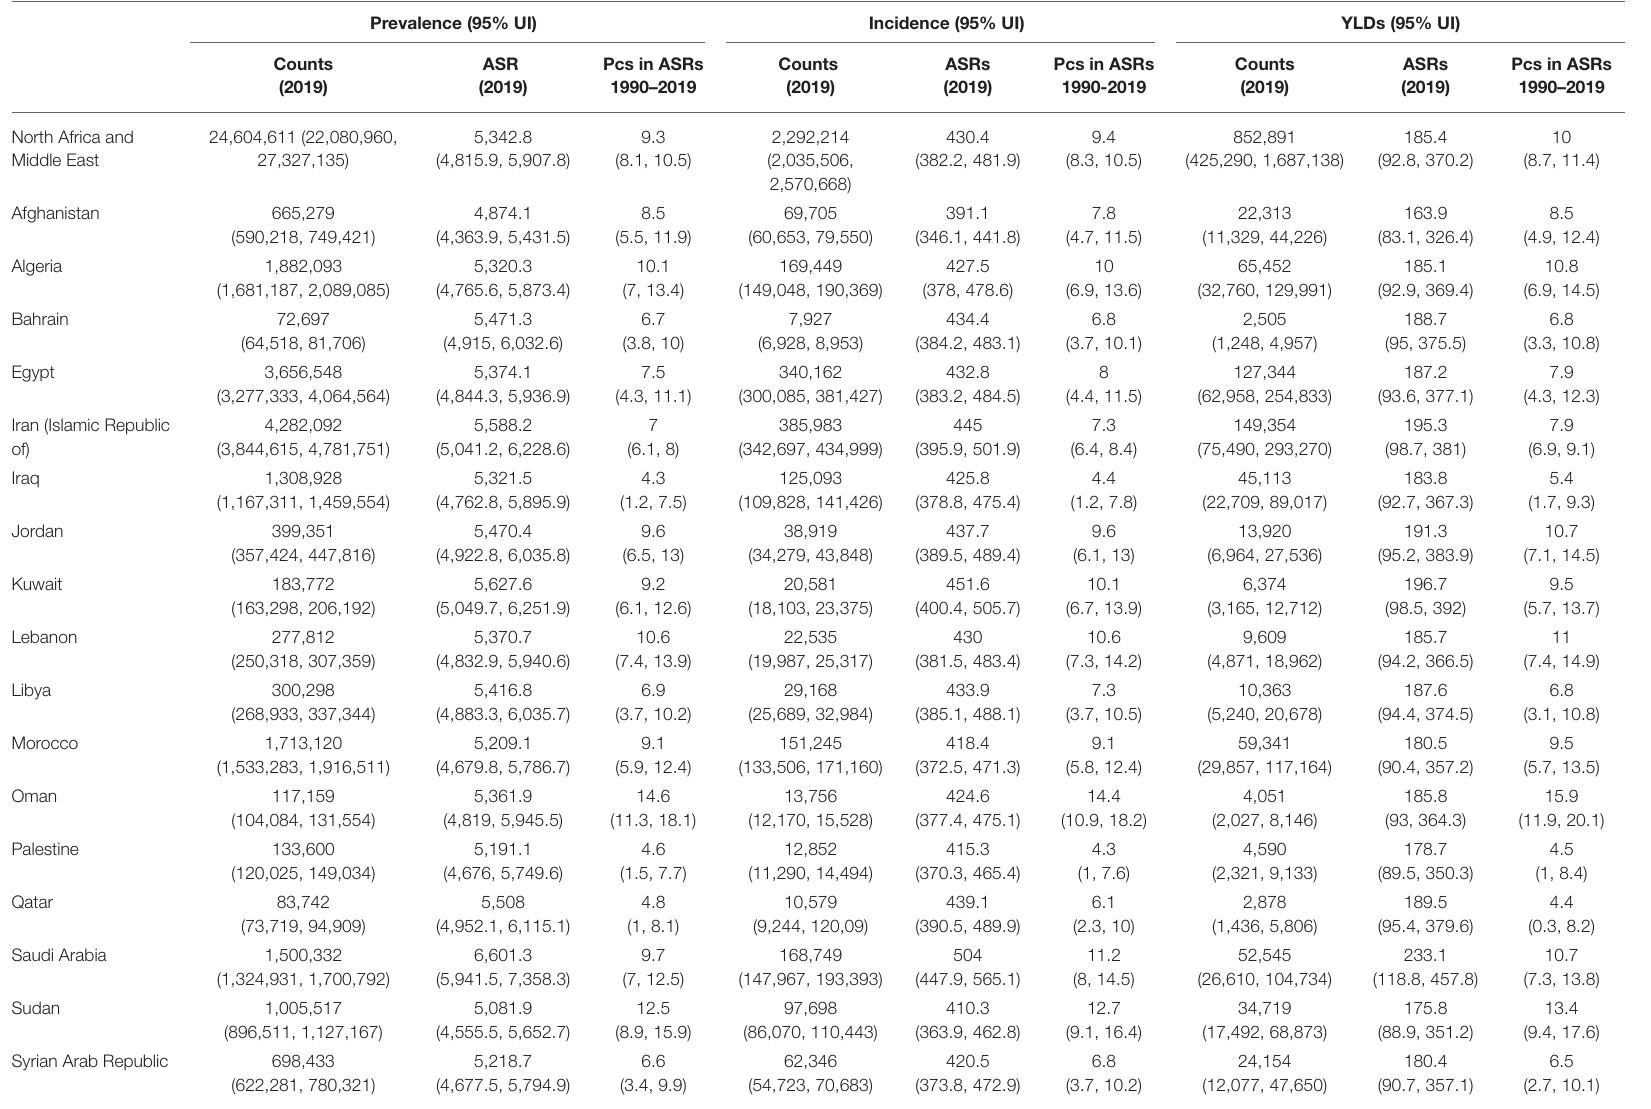
TABLE 1 | Prevalent cases, incident cases and YLDs due to osteoarthritis in the Middle East and North Africa region in 2019 and percentage change of age-standardized rates during 1990–2019 (generated from data available from